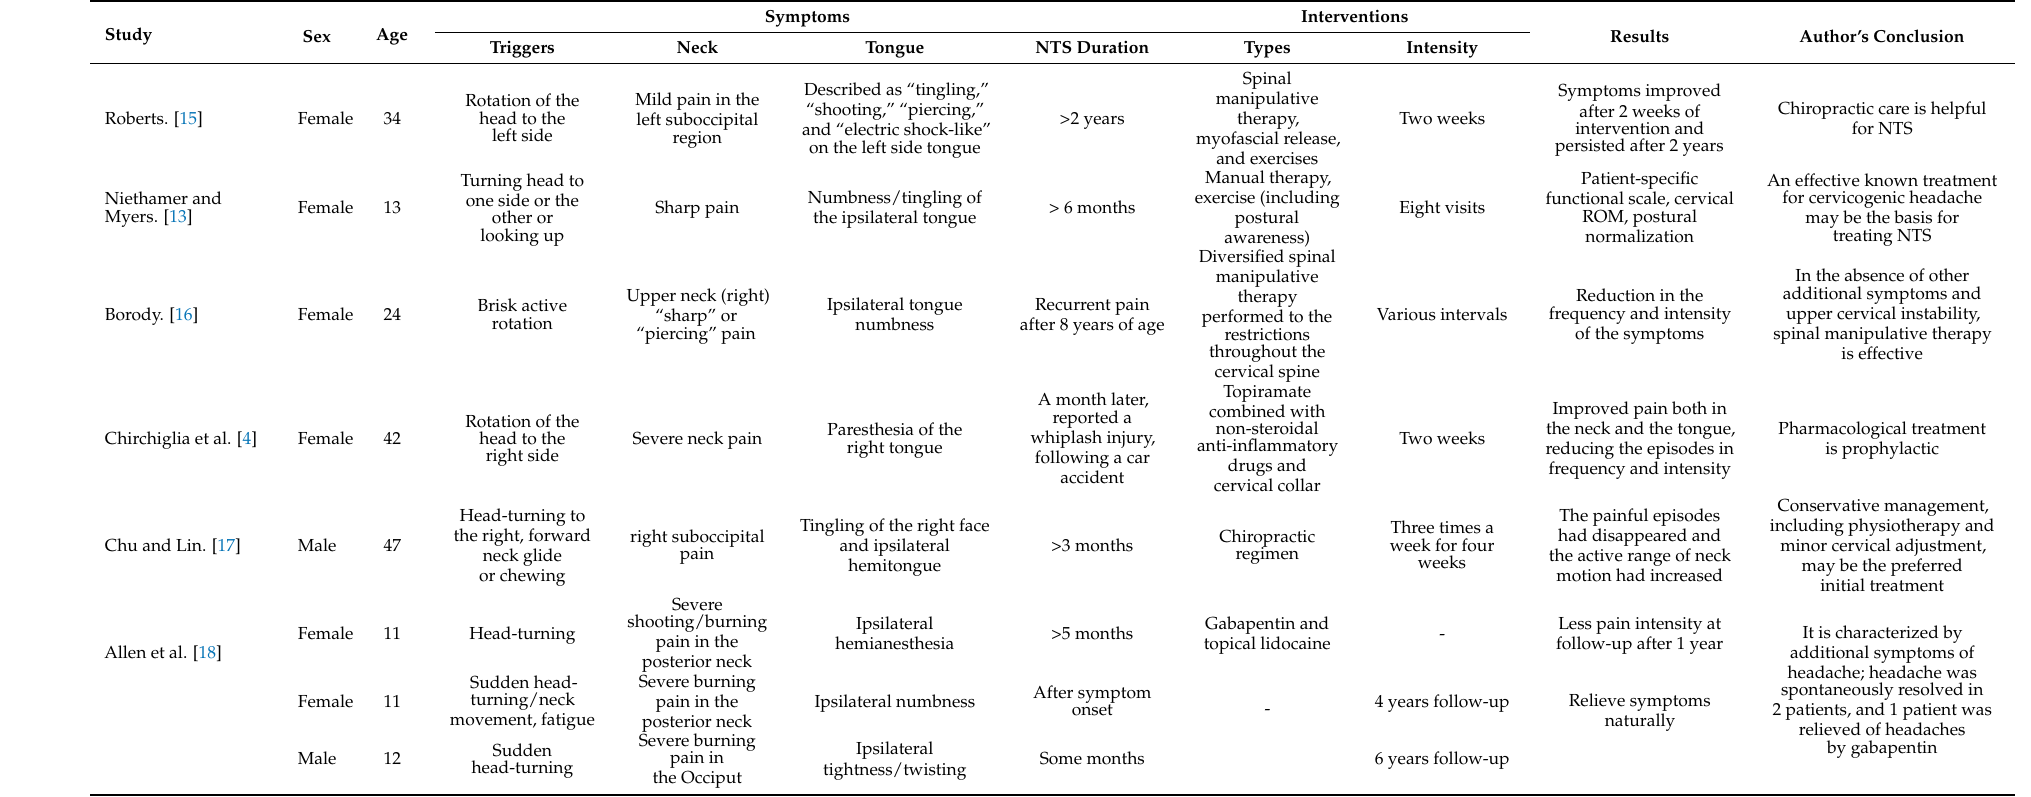
Table 2. Characteristics of the case